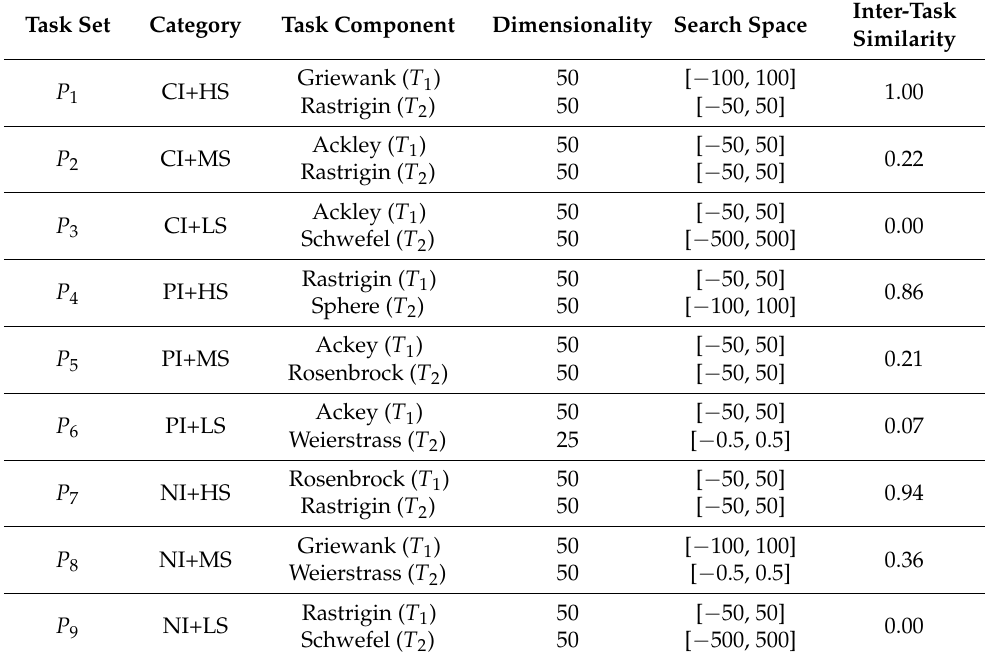
Table 1. Summary of properties of problem pairs in test suite